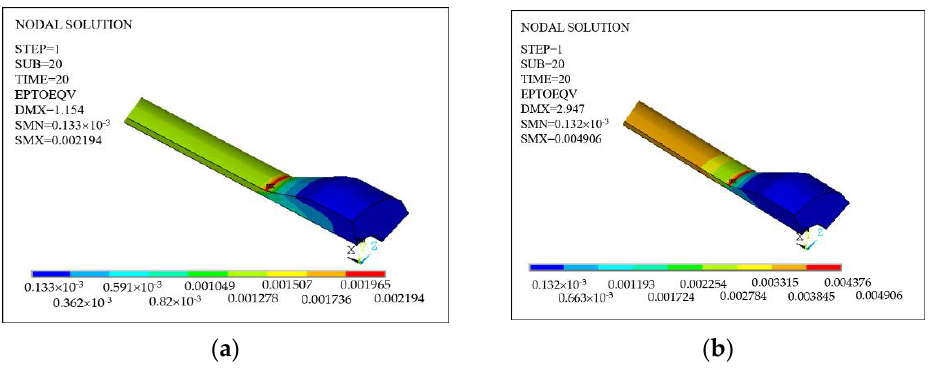
Figure 2. Finite element simulated von Mises strain contour of notched sheet (X-direction, T = 20 °C, b = 20 mm, r = 25 mm, ratio = −1). ( a ) Elastic analysis; ( b ) elastoplastic analysis.